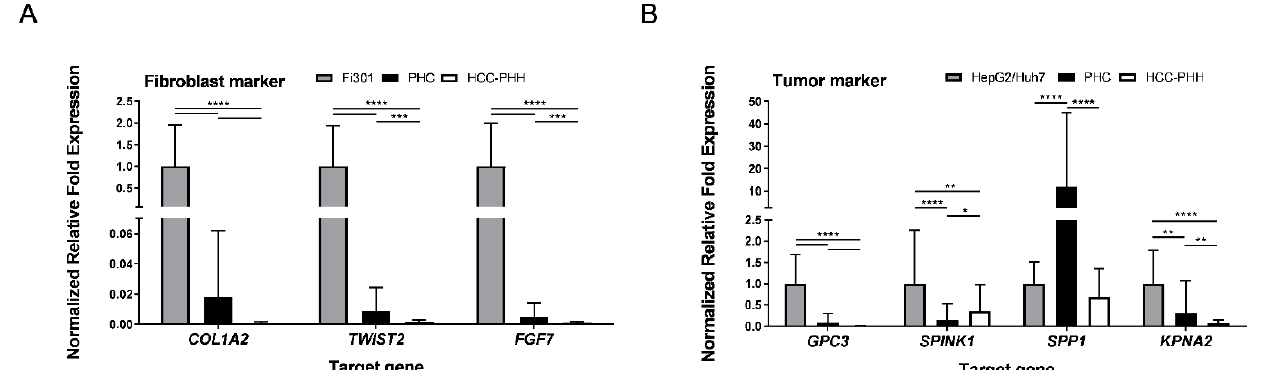
Figure 2. Characterization of isolated primary cells by genetic markers. HCC-PHHs (N = 8) and PHCs (N = 6) were analyzed after cell isolation using RT-qPCR. Relative mRNA expression levels of ( A ) fibroblast markers (COL1A2, TWIST2, FGF7) and ( B ) tumor markers (GPC3, SPINK1, SPP1, KPNA2) were determined. Fi301 (N = 3) and HepG2/Huh7 (N = 6) cells were used as positive controls. Values are means + SD, n = 3, two- way ANOVA and post hoc Šidák correction or Tukey’s test, statistical analyses were conducted on ΔC T values, * p ≤ 0.0332, ** p ≤ 0.0021, *** p ≤ 0.0002, **** p < 0.0001. Abbreviations: PHC, primary human hepatoma cell; HCC, hepatocellular carcinoma; PHH, primary human hepatocyte; COL1A2, collagen type I alpha 2 chain; TWIST2, twist family BHLH transcription factor 2; FGF7, fibroblast growth factor 7; GPC3, glypican-3; SPINK1, serine protease inhibitor Kazal type 1; SPP1, secreted phosphoprotein-1; KPNA2, karyopherin subunit alpha 2.